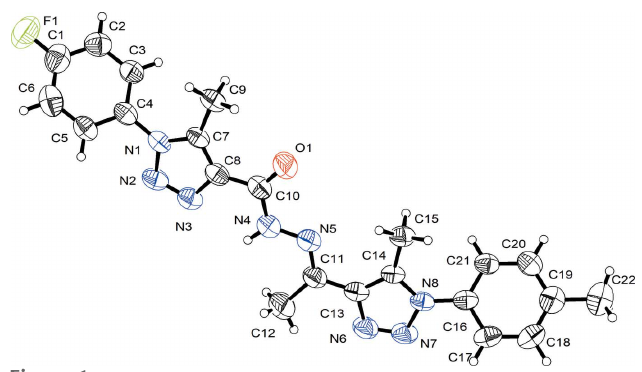
Figure 1 An ORTEP representation of the asymmetric unit showing 50% probability ellipsoids.